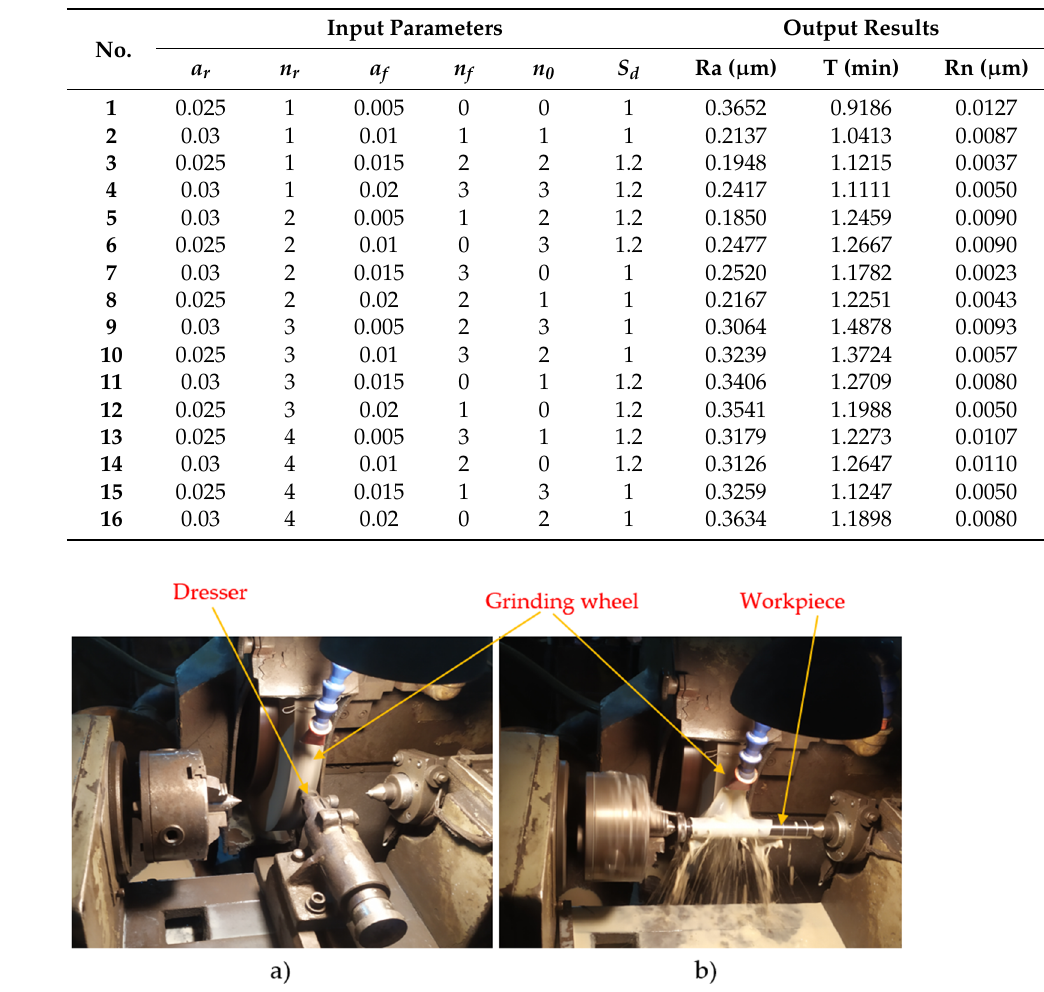
Figure 2. Experimental setup. ( a ) Setup for wheel dressing; ( b ) Setup for cylindrical external grinding. Table 3. Experimental matrix and output results.